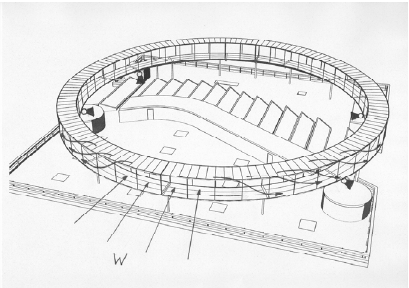
Fig.8: Transfer of wind loads; the wind loads act against the glass walls.